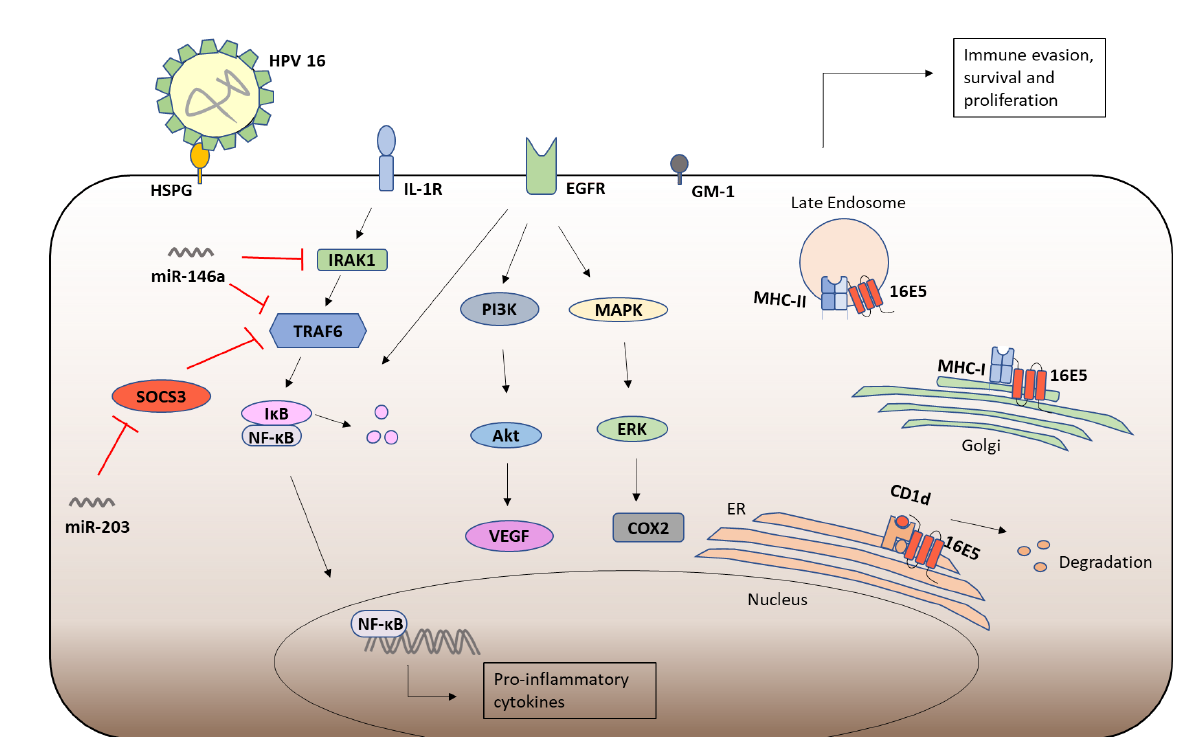
Figure 5. Immune modulation by HPV-16 E5. Following infection with HPV-16, which enters the cell via HSPG receptors, the ion channel E5 subverts the immune response. E5 sequesters CD1d in the ER, inhibits its trafficking to the cell membrane and promotes its proteasomal degradation. Similarly, 16E5 downregulates the cell surface expression of MHC class I and MHC class II molecules, thereby evading recognition by T cells. 16E5 upregulates the cell surface expression of GM1 which inhibits CD8+ T cell responses and contributes to EGFR activation. EGFR activated PI3K and MAPK signaling leads to COX-2 and VEGF upregulation, promoting cell survival and proliferation. Furthermore, 16E5 modulates miRNA expression. By repressing miR-203, 16E5 induces SOCS3 which inhibits NF- κ B activation by targeting the signaling intermediate TRAF6. Furthermore, E5 enhances miR-146a which inhibits NF- κ B activation by targeting signaling intermediates, IRAK1 and TRAF6. Thereby, E5 attenuates inflammation, subverts the activation of an adaptive immune response and promotes cell survival and